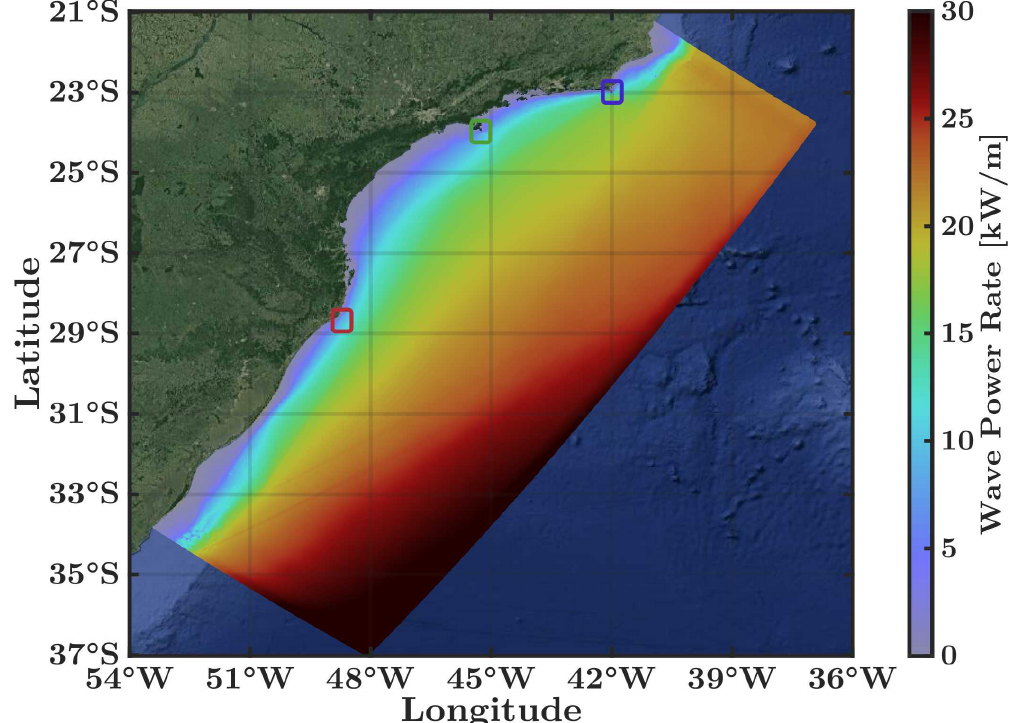
Figure 8. Mean value of wave power rate P w (kW/m) over 18 years. Selected regions are highlighted using a black rectangle (Laguna), white rectangle (Ilhabela) and red rectangle (Farol Island).